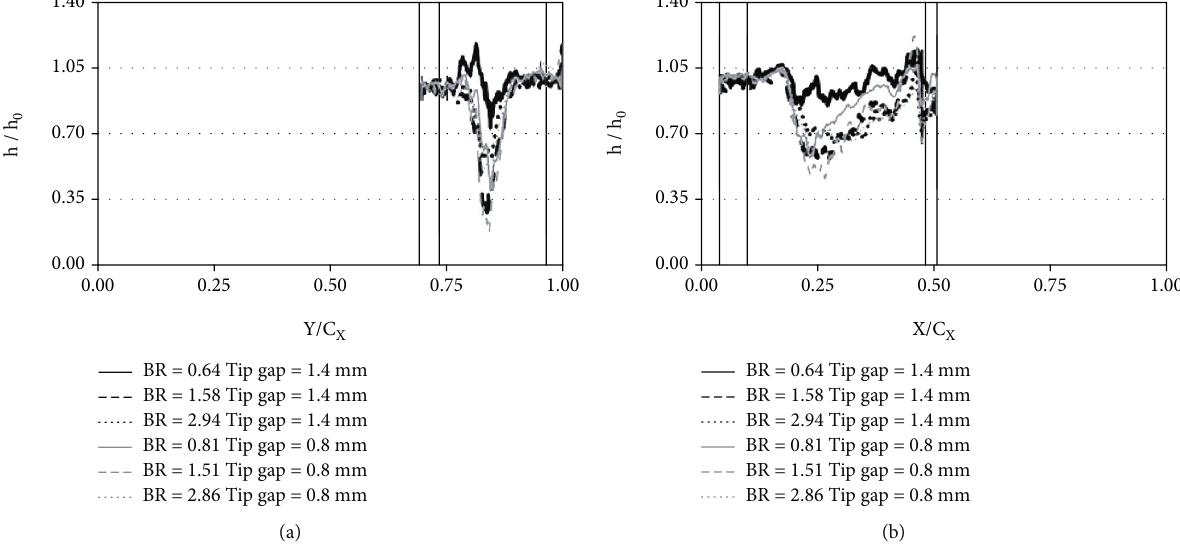
Figure 9: Local heat transfer coe ffi cient ratio distributions for the A1 blade for di ff erent tip gaps and blowing ratios. (a) Along line A. (b) Along line